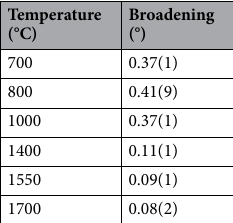
Table 2. Broadening of the (4 2 0) main peak, as extracted from the XRD patterns, as a function of the calcination